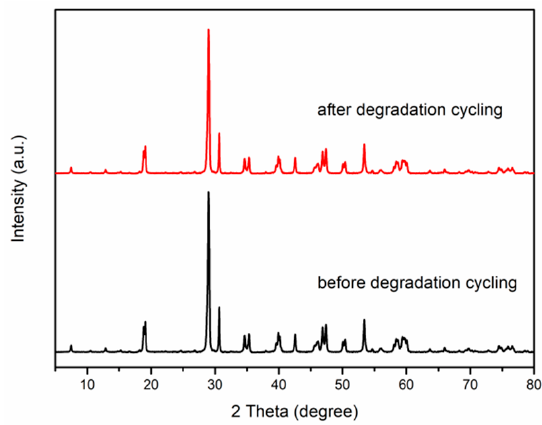
Figure 6. XRD patterns of ZIF-8@BVO composite before and after three cycles.